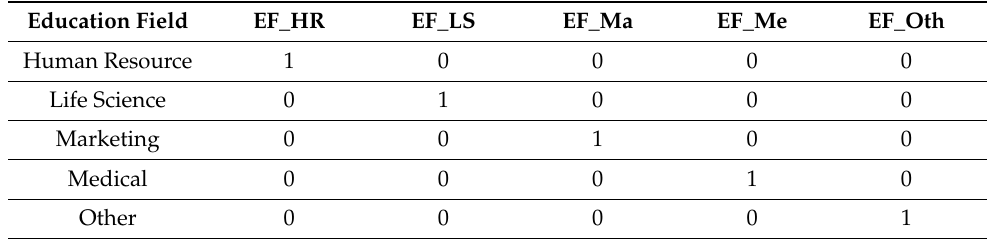
Table 2. Categorical Feature Education Field Conversion to Binary